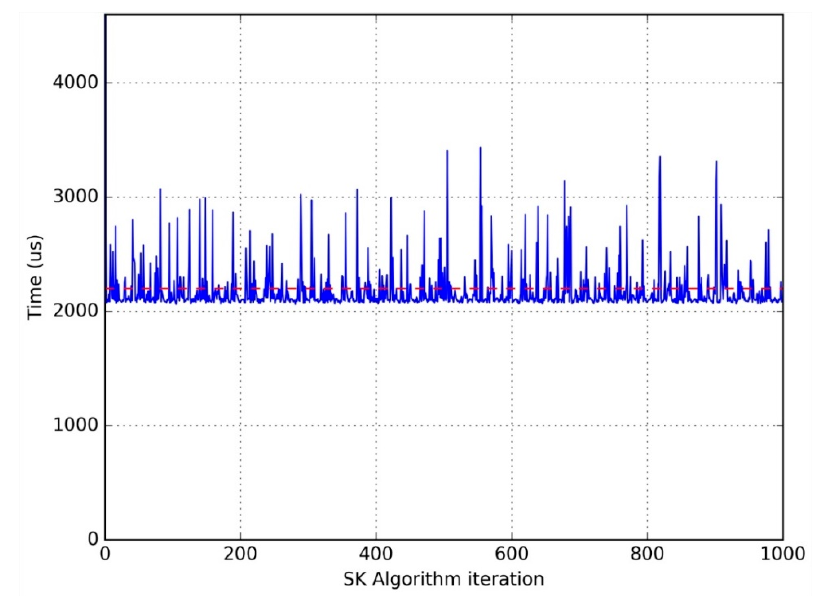
Figure 6. Elapsed time to calculate each iteration. Atom N270.